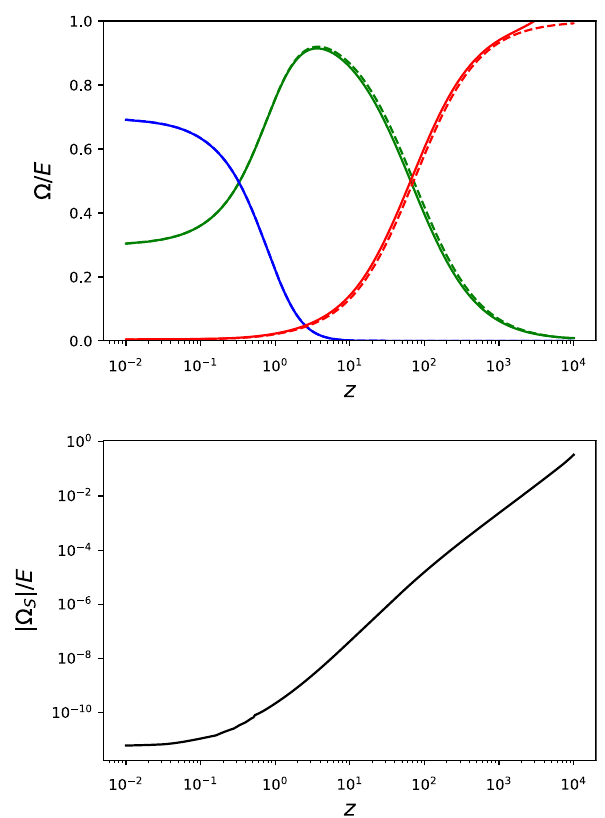
Fig. 1 Upper: numerical evolution of the (cid:14) m (green), (cid:14) (cid:2) (blue) and (cid:14) r (red)forthetorsionalDEmodel.Lower:the